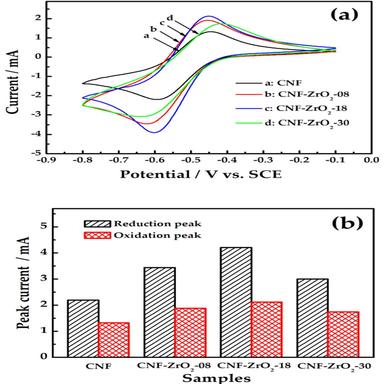
CV curves for GCE modified by different samples in 1.6 mol L1 V3þ þ 3.0 mol L1 H2SO4 electrolyte at a scan rate of 10 mV s1 (a), comparison of the relevant peak current (b).